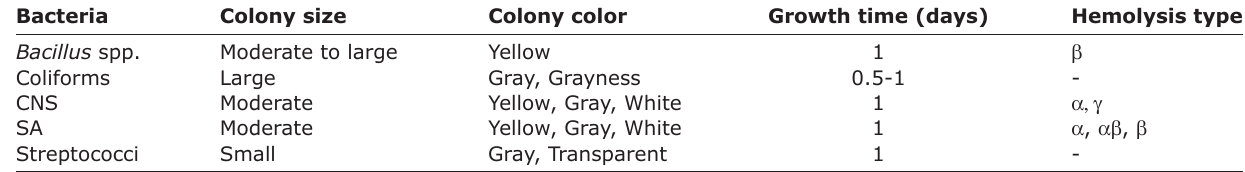
Table-2: Growth characteristics and hemolysis type of each bacterium for agar culture identification. Bacteria